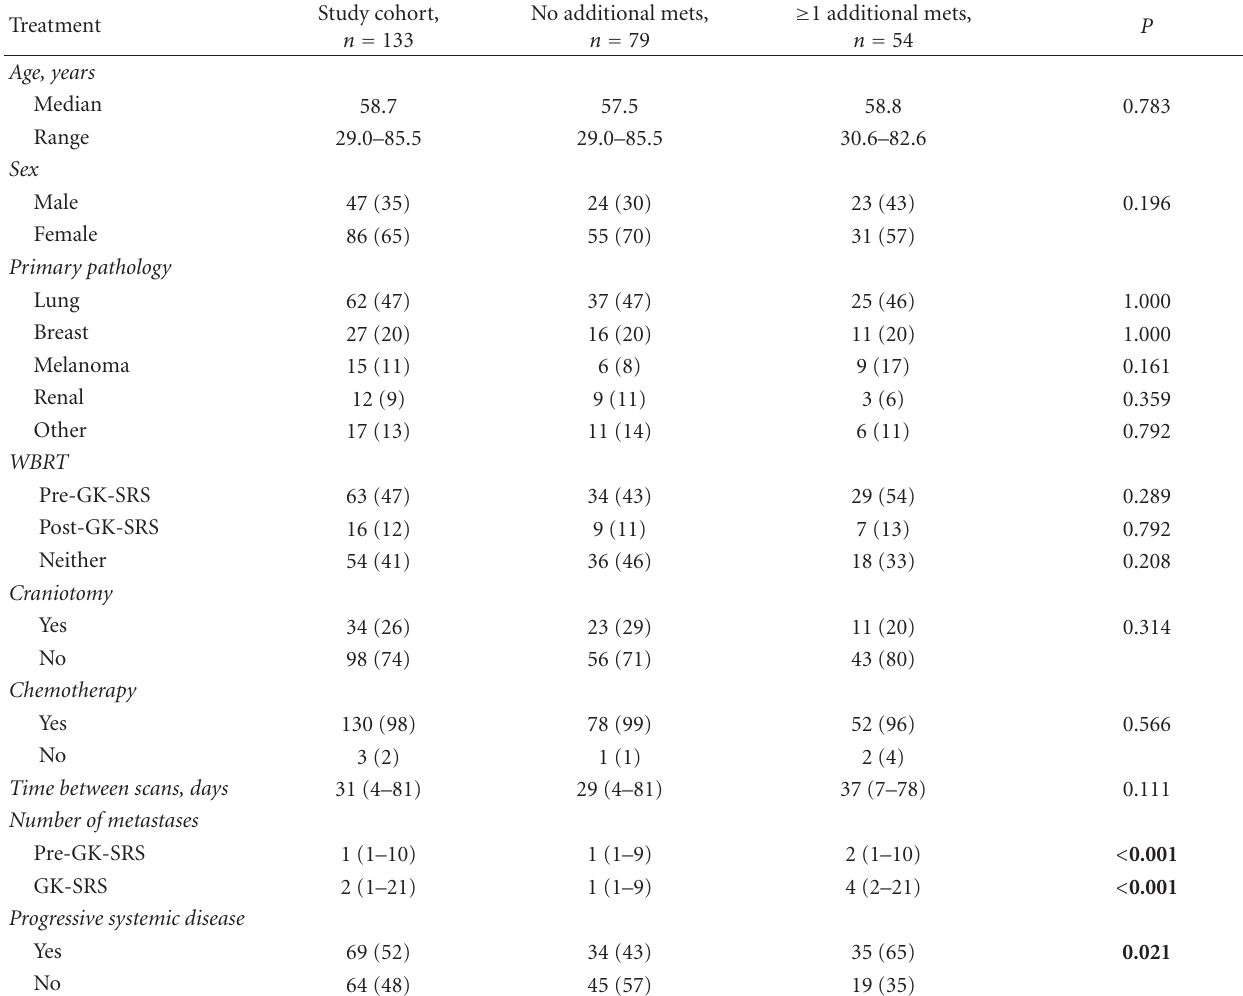
Table 1: Study population and treatment characteristics ∗